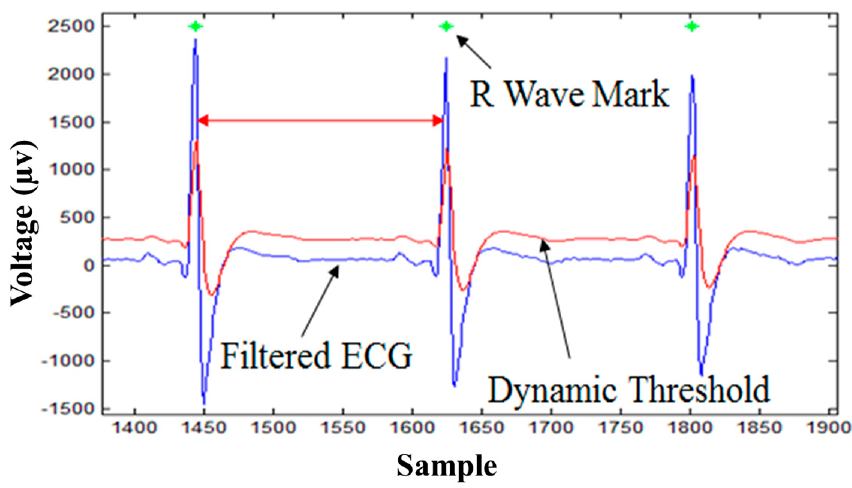
Figure 4. Approach of identifying R-peak using the R-wave detection algorithm. The green star denotes the derived local maximum of the R-wave, which is the R-peak.